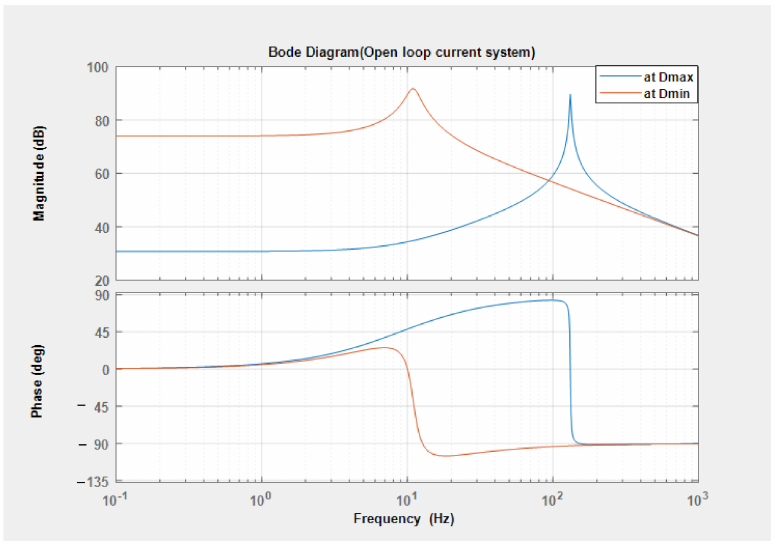
Figure 11. Bode plot of the open loop current system with different duty cycle. Figure 12 depicts the block diagram of the inner current-control loop using the PI controller.